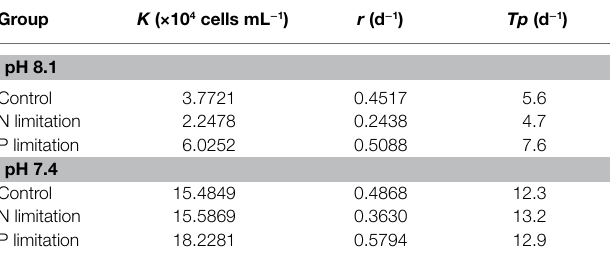
TABLE 4 | Regressions of the logistic model on K. mikimotoi population growth under seawater acidification conditions when exposed to different nutrient